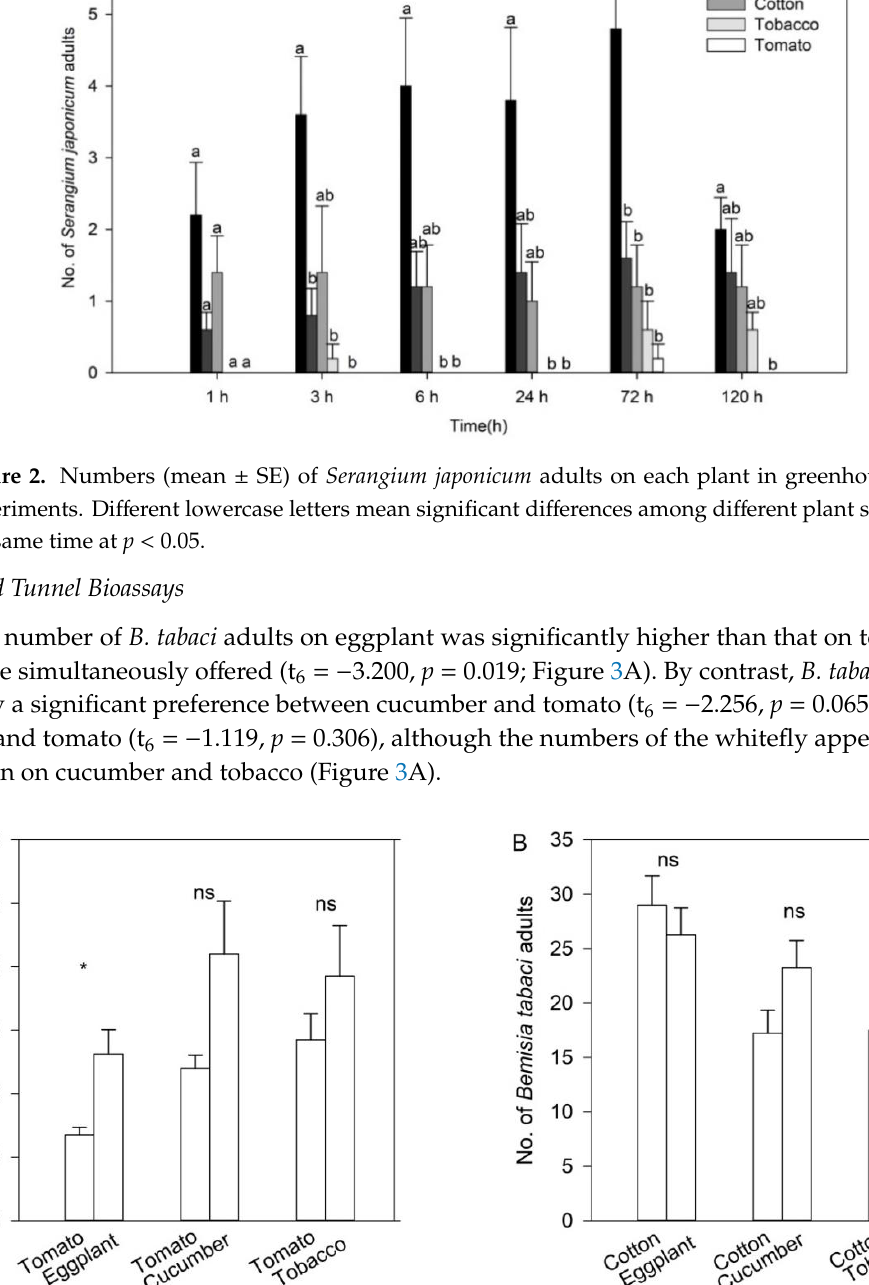
Figure 3. Numbers (mean ± SE) of Bemisia tabaci adults on each plant in the wind tunnel assays. ( A ) Non-preferential tomato versus preferential eggplant, cucumber and tobacco. ( B ) Non-preferential